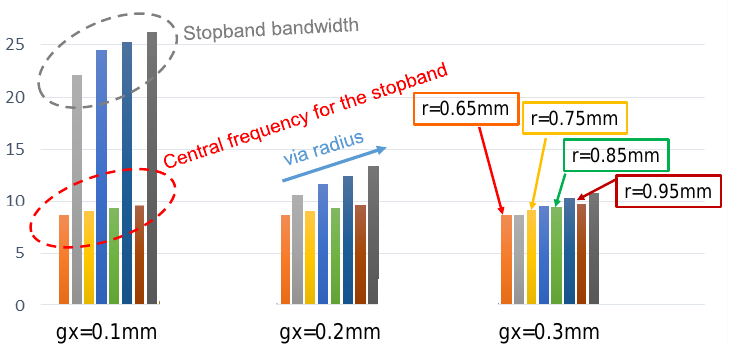
Figure 12. Stopband central frequency and its fractional bandwidth (assuming a rejection level greater than 10 dB) as a function of: the via radius (r) and the gap between the patch and microstrip line (gx). Other main parameters (rx = 4.9 mm, ry = 6.5 mm, gy = 2 mm, and d = 0.3